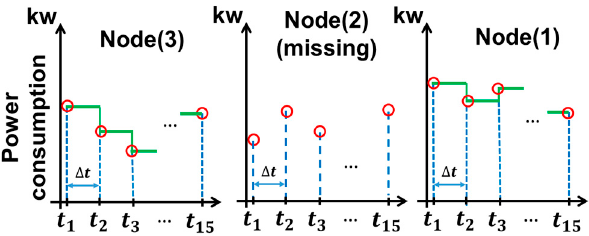
Figure 2. Example of time-series active power data.